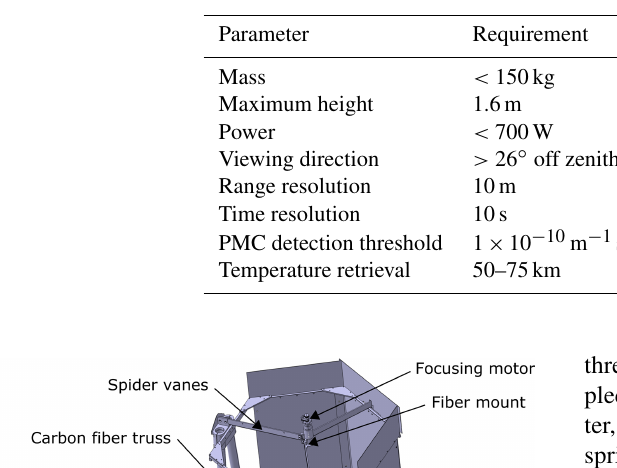
Table 1. BOLIDE instrument requirements and actual performance. The PMC detection threshold is defined for 30s time resolution and 100m vertical resolution.